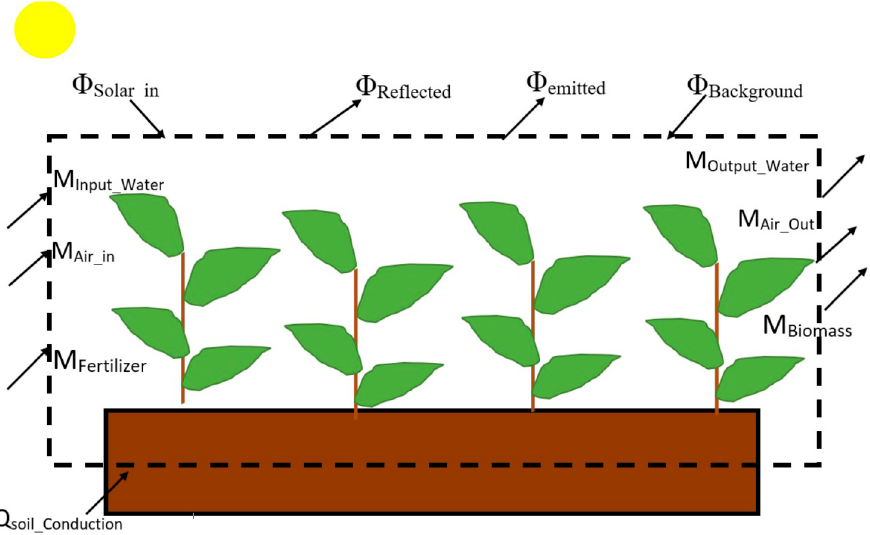
Figure 2. Mass and energy flows of a crop plant system [59].